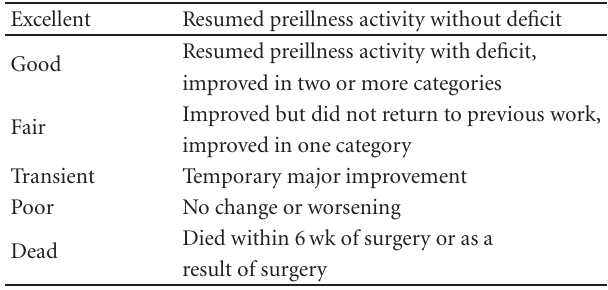
Table 2: Black Scale for assessment of shunt outcome